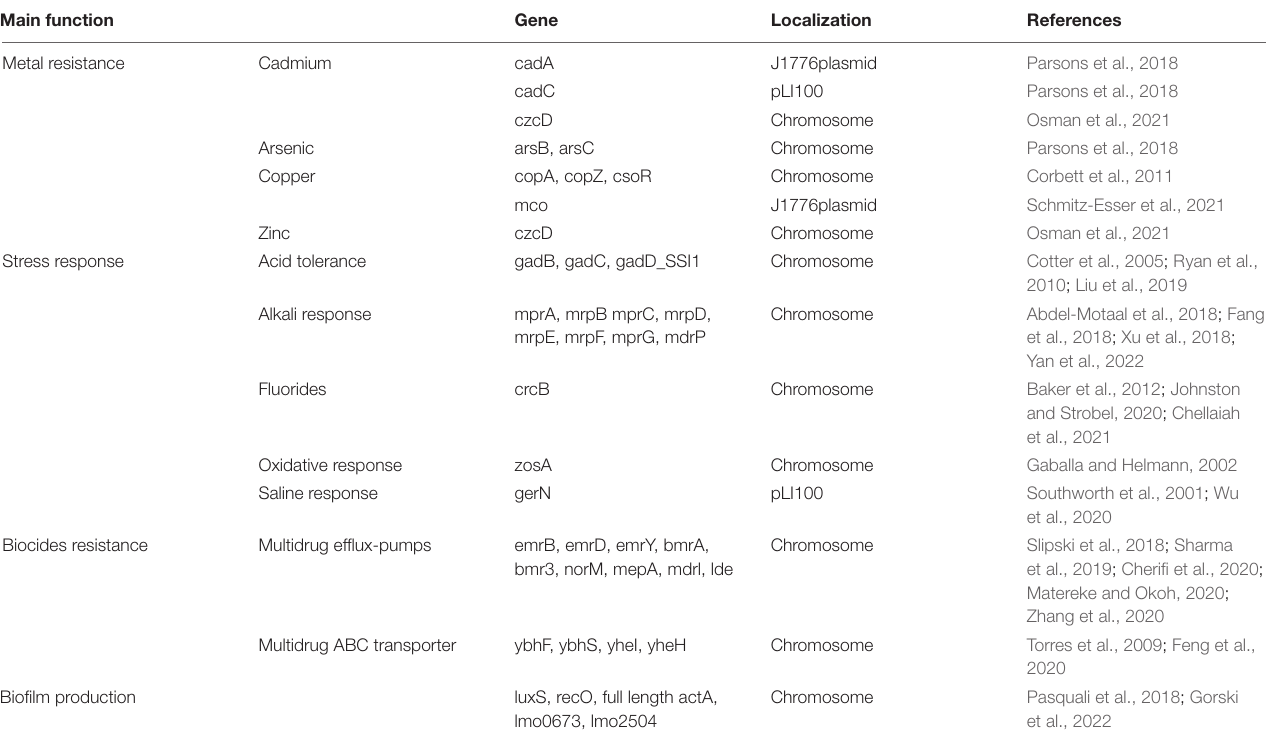
TABLE 1 | Relevant features for environmental persistence of different clusters conveyed and not by